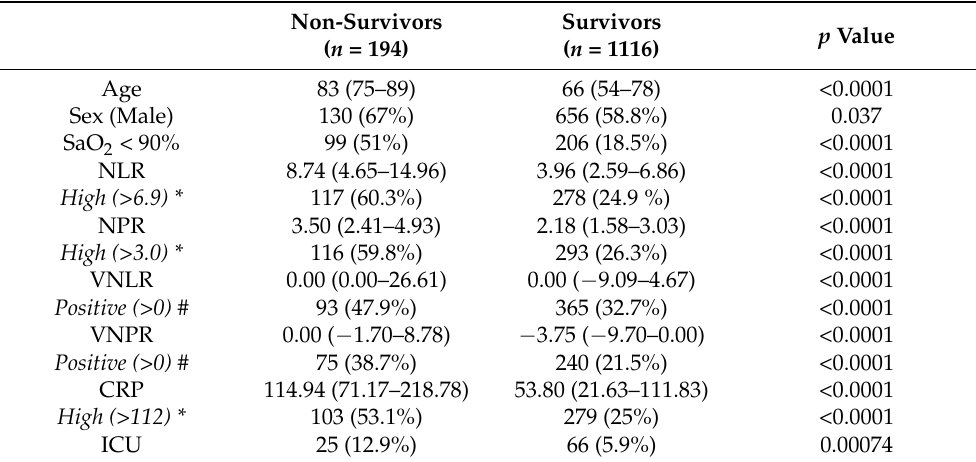
Table 2. Baseline Demographics, clinical and laboratory characteristics training cohort. Median value (interquartile range).